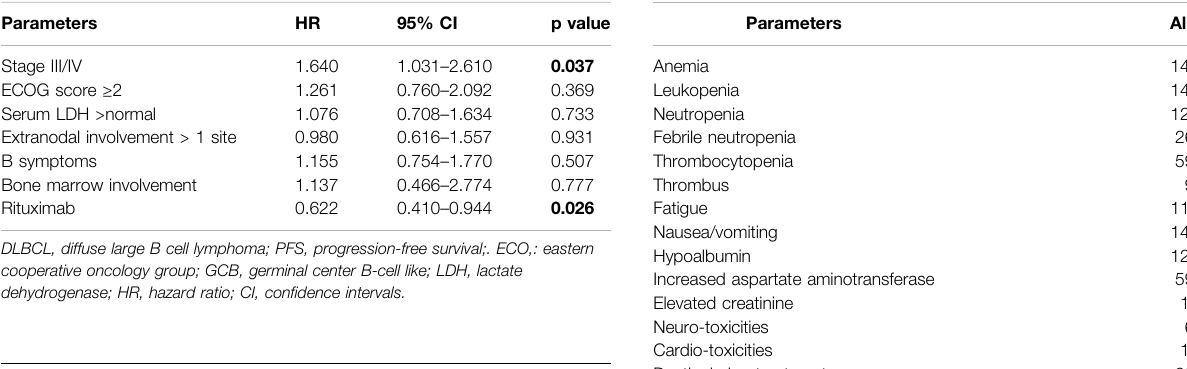
TABLE 5 | Multivariate analysis of OS in patients with DLBCL (n=239).